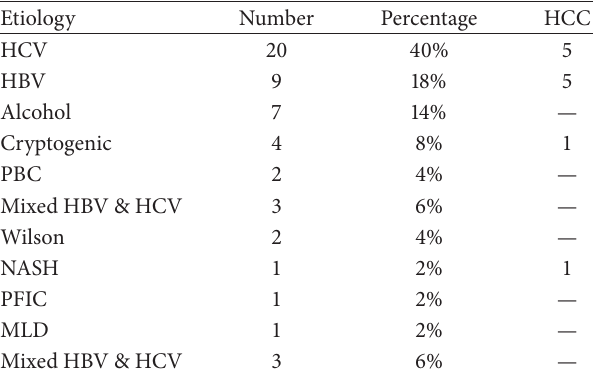
Table 1: Etiopathological association of explant liver and